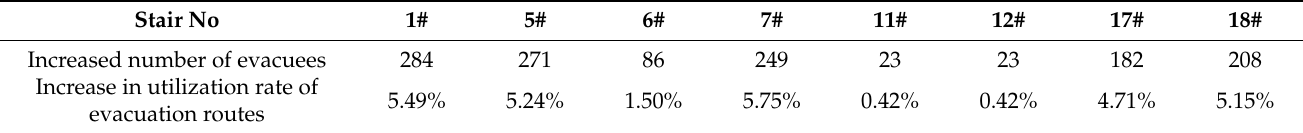
Table 6. Increase in number of evacuees and channel utilization rate of each